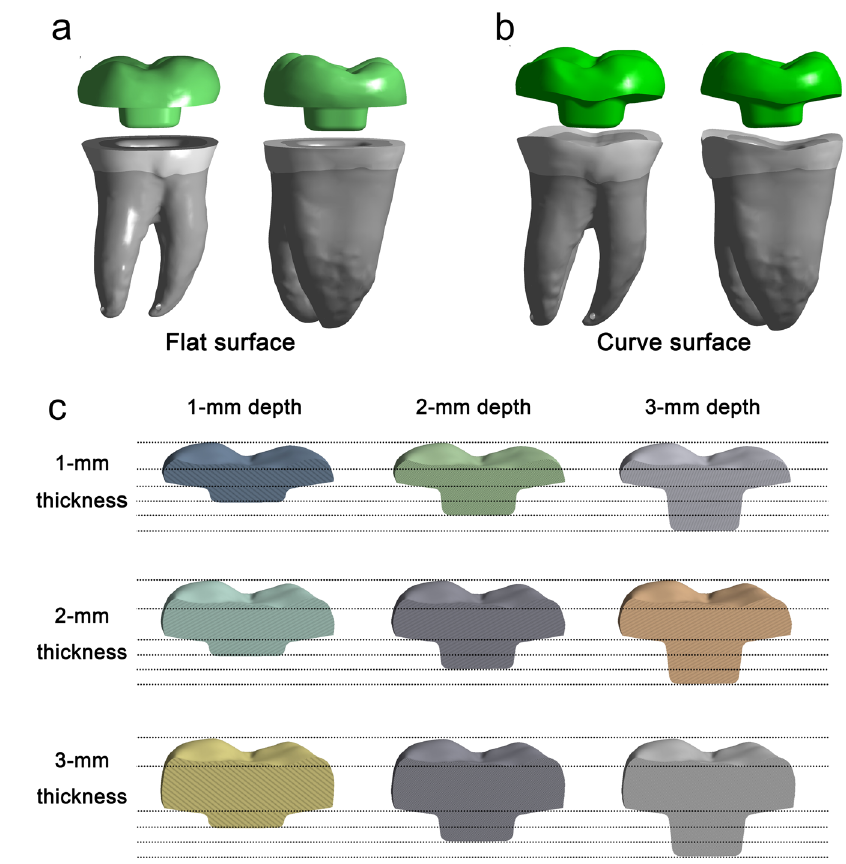
Fig. 1 Schematic illustration of mandibular molar with endocrown restorations. Two types of butt margin of endocrown with 2-mm occlusal thickness and 2-mm pulp chamber extension depth were devised: fl at surface of butt margin ( a ) and curve surface of butt margin ( b ). Nine types of endocrown restoration with 1- mm, 2-mm, or 3-mm pulp chamber extension depth in combination with 1-mm, 2-mm, or 3-mm occlusal thickness were devised by a fi nite element analysis software (FEA, ANSYS, v18.0; Swanson Analysis Inc)